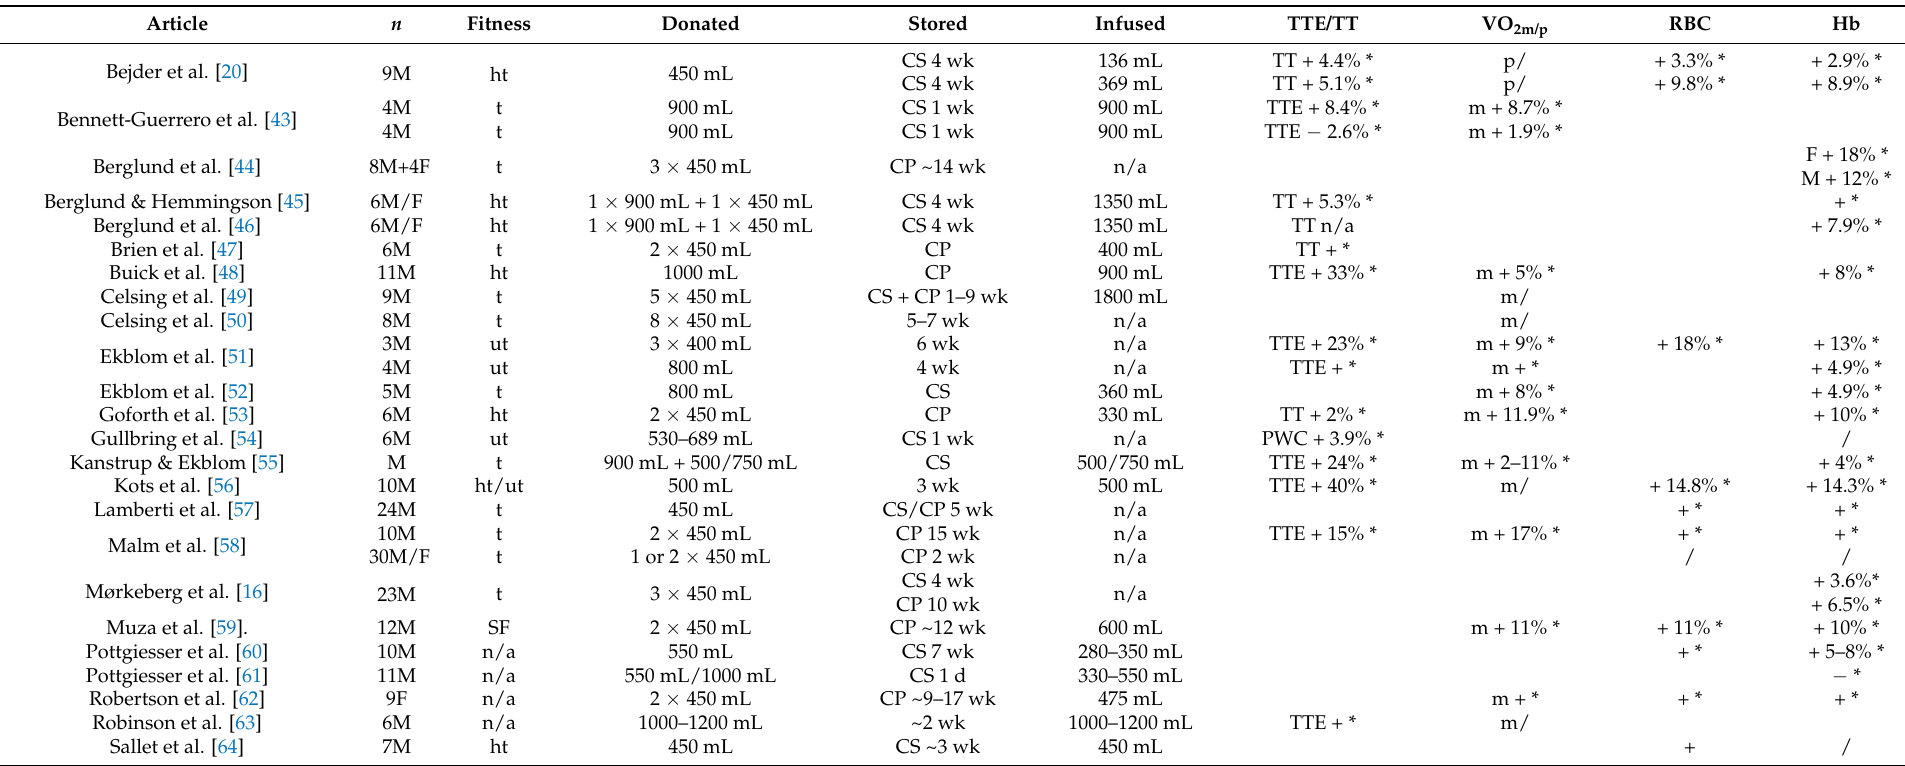
Table 1. Overview of analyzed original articles related to effects of blood storage techniques and storage duration on performance outcome in autologous blood doping